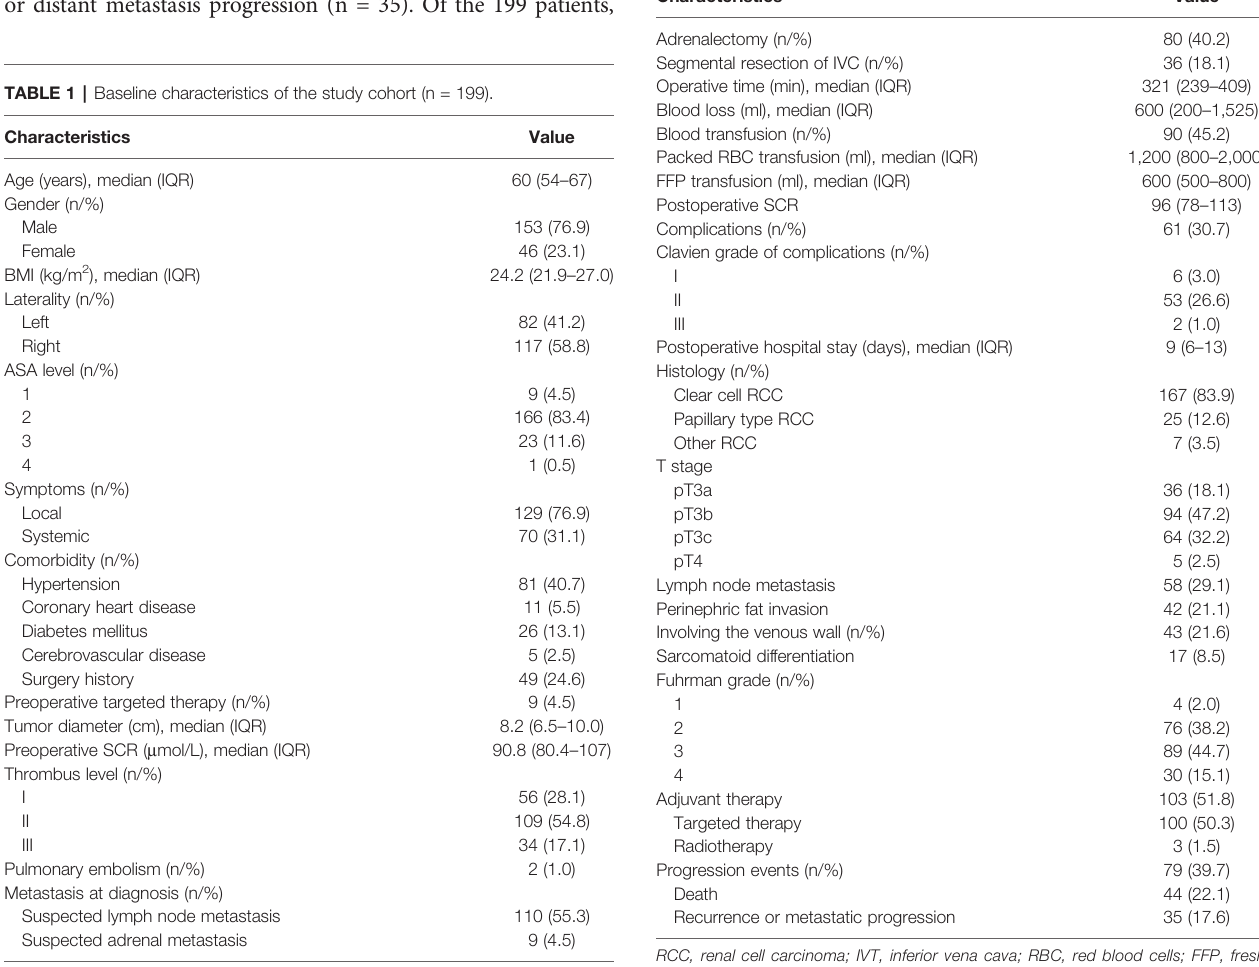
TABLE 2 | Surgical, pathological, and oncologic outcomes of the study cohort.